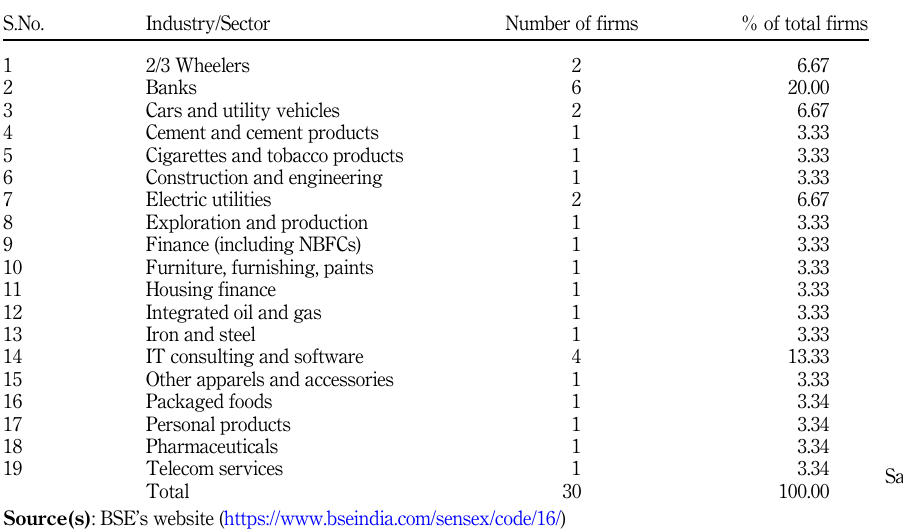
Table 1. Sample composition